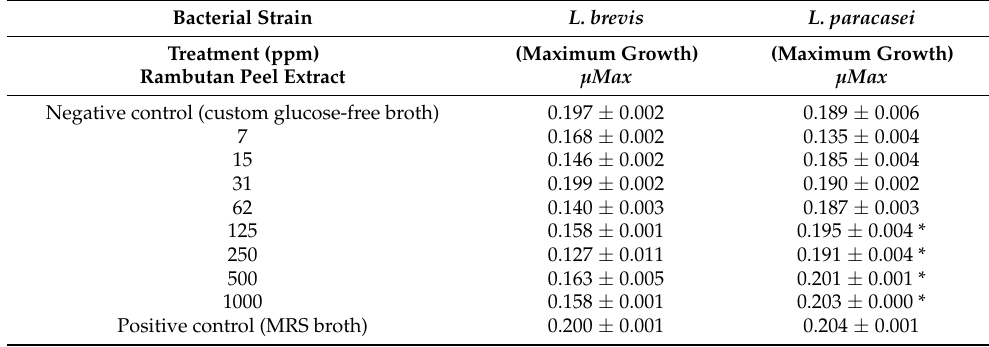
Table 3. Maximum growth and maximum growth ratio gathered from the prebiotic assay. A Tukey mean comparison test was performed on L . paracasei and L . brevis bacterial strains with a significance level of p < 0.05 (*), indicating that there is no significant difference between the treatment and positive control. Bacterial Strain L. brevis L.